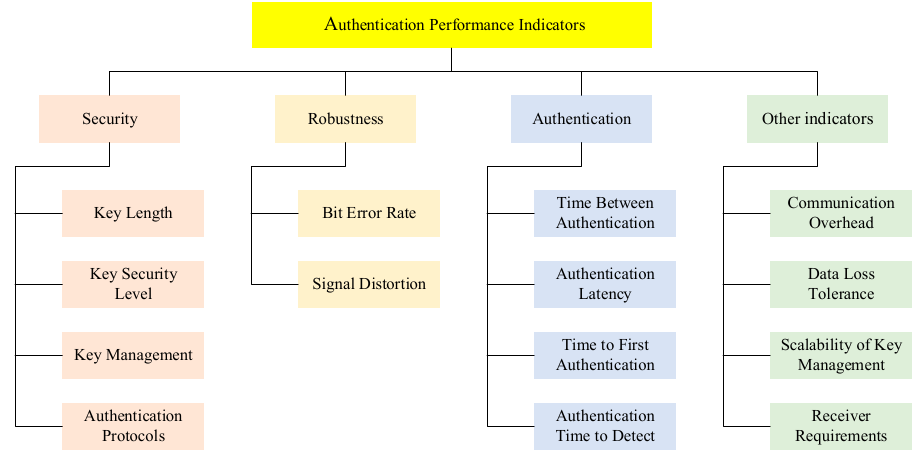
Figure 14. Authentication performance indicators.